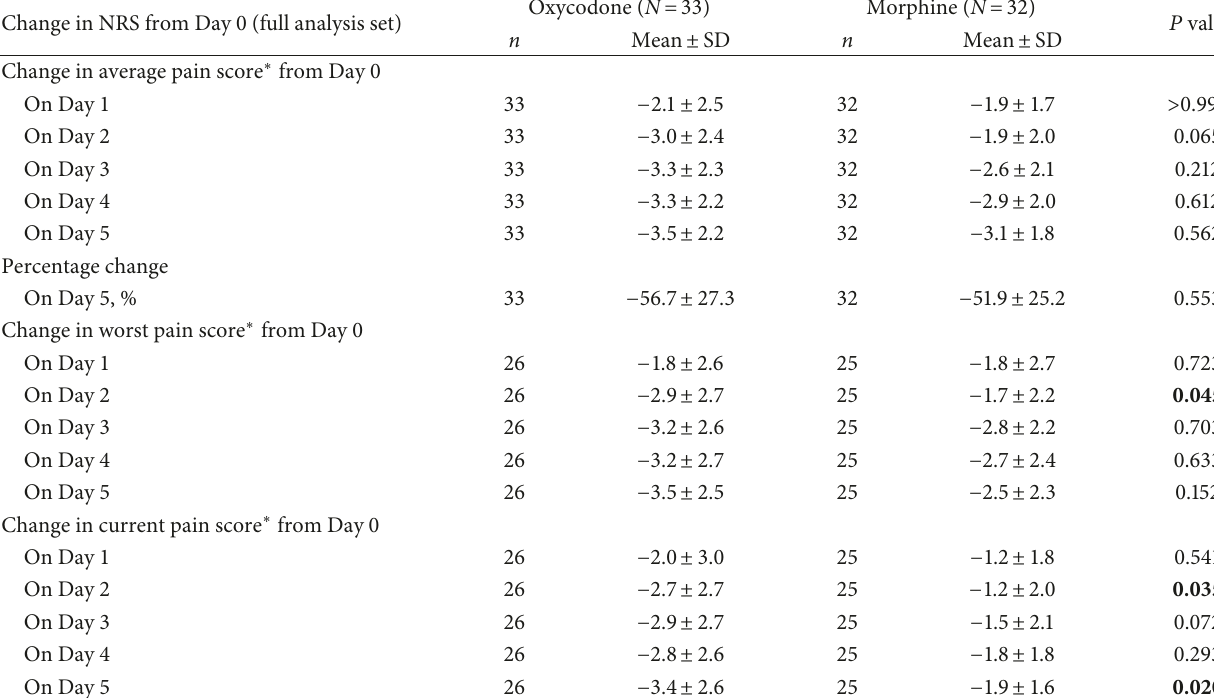
pain scores from baseline (Day ∗